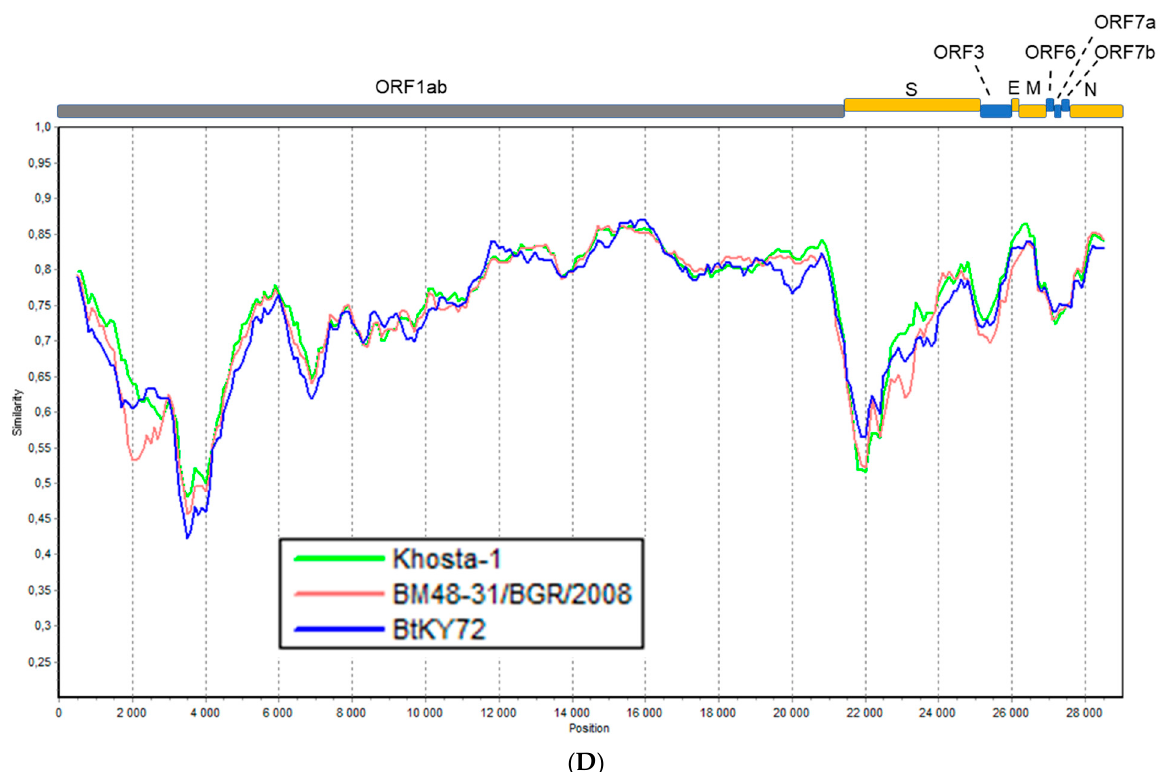
Figure 2. Simplot analysis of Khosta-1 and Khosta-2 with SARS-CoV, SARS-CoV-2, and related viruses. RaTG13, HKU3, and Rs672 were used as representatives of bat SARS-CoV-like viruses from Asia. ( A ) Khosta-1 was used as a query sequence, and SARS-CoV, RaTG13, HKU3, Rs672, and SARS-CoV-2 were used as reference sequences. ( B ) Khosta-2 was used as a query sequence, and SARS-CoV, RaTG13, HKU3, Rs672, and SARS-CoV-2 were used as reference sequences. The sequences of the ORF8 gene, which is absent in Khosta-1 and Khosta-2, were removed from alignment before analysis. ( C ) Khosta-1 was used as a query sequence, and Khosta-2, BM48-31/BGR/2008, and BtKy72 viruses were used as reference sequences. ( D ) Khosta-2 was used as a query sequence, and Khosta-1, BM48-31/BGR/2008, and BtKY72 were used as reference sequences. The analysis was performed using the Kimura (two-parameter) model, with a window size of 1000 bases and a step size of 100 bases. Table 2. Identity (%) of deduced amino-acid sequences of proteins of Khosta-1 and Khosta-2 viruses with certain representatives of the Sarbecovirus subgenus (lineage B of betacoronaviruses).